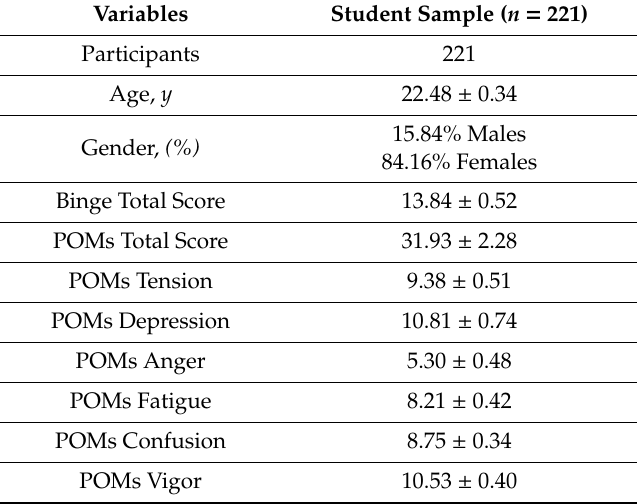
Table 1. Participants’ characteristics, binge eating, and Profile of Mood State questionnaire (POMS) total scores and